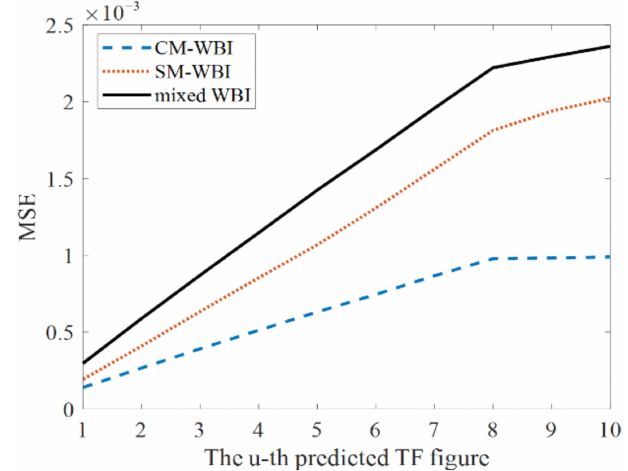
Figure 8. The WBI prediction performance of PredRNN against the prediction length for the chirp- modulated WBI (CM-WBI), the sinusoidal-modulated WBI (SM-WBI) and the mixed WBI.